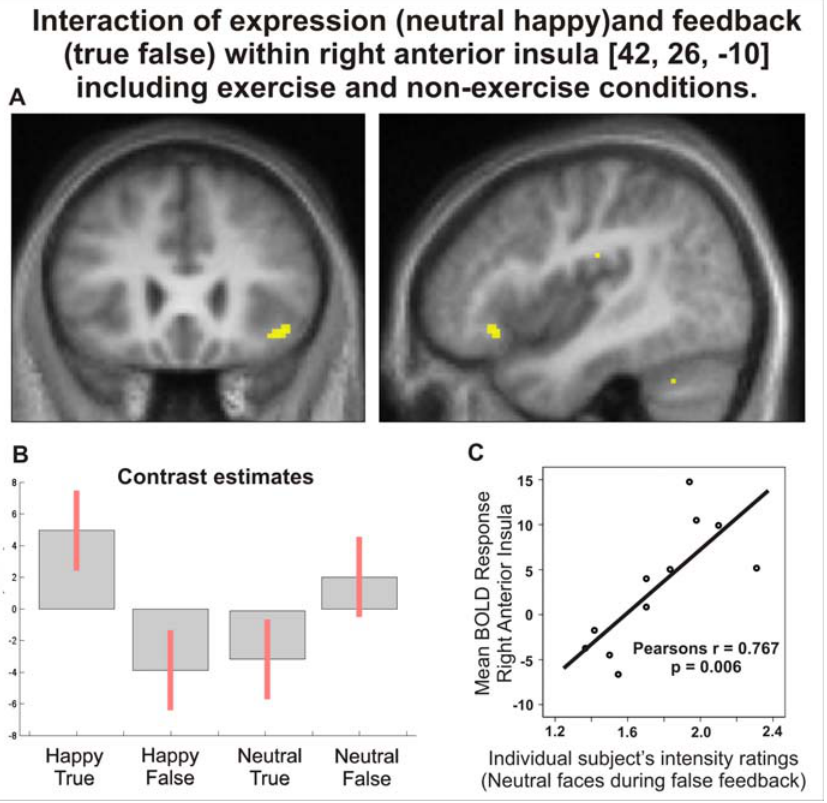
Figure 4. Interaction of Emotion and Feedback Veracity within Right Anterior Insula. Within the Right Anterior Insula, a significant interaction of emotion (happy neutral) and feedback (true false) was observed when considering both exercise and non-exercise conditions. This interaction closely resembles the right anterior insula interaction previously observed within the non-exercise condition alone. A) Coronal and sagittal sections, B) Contrast estimates. C) When considering both the exercise and non-exercise conditions, individual subjects’ ratings of neutral faces during false is significantly correlated with BOLD responses within the right anterior insula cortex (across subjects).